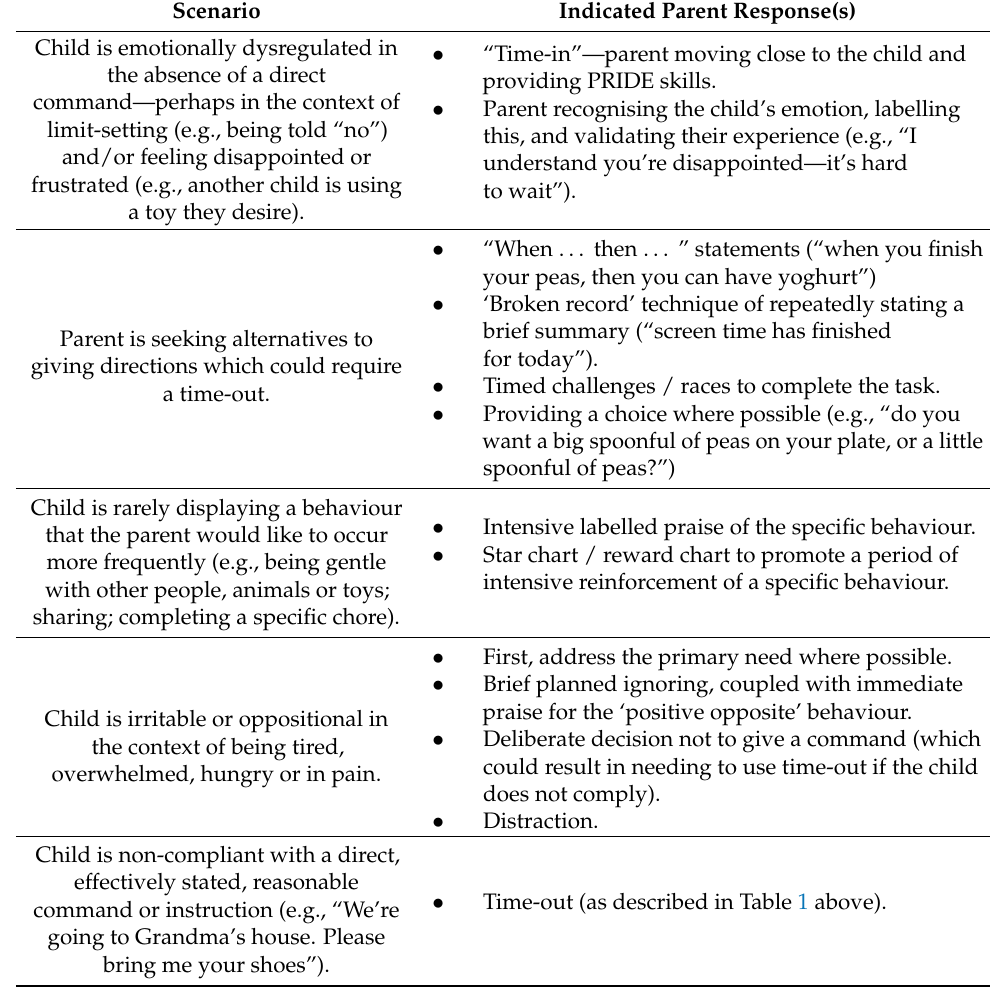
Table 2. Examples of scenarios to demonstrate the use of “time in” and “time-out” across a spectrum of